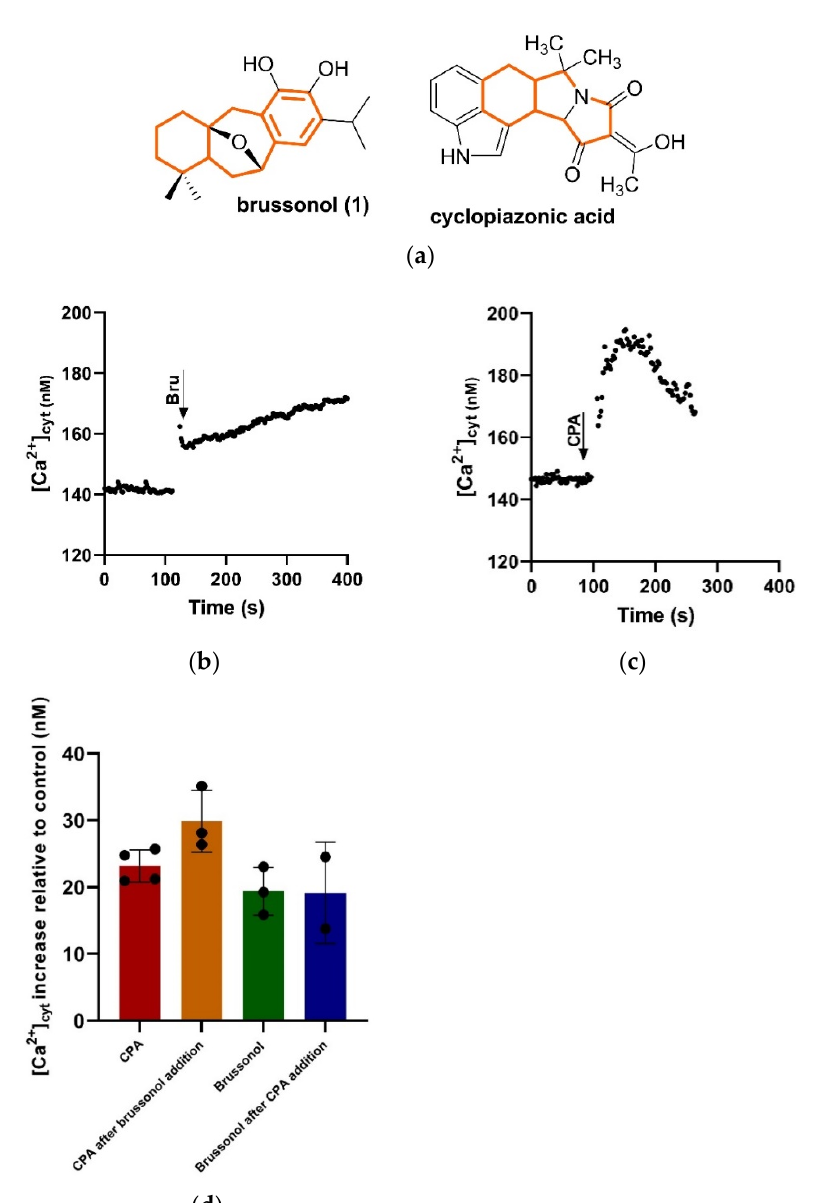
Figure 8 . Effect of brussonol on the cytosolic Ca 2+ mobilization in P. falciparum loaded with Fluo-4 AM calcium indicator. ( a ) Chemical structure of brussonol and CPA. The fused rings are highlighted for comparison purposes. Representative traces of [Ca 2+ ] cyt rise induced by 10 μ M brussonol ( b ) and 10 μ M CPA ( c ) in MOPS buffer containing Ca 2+ . ( d ) Histograms of the increase in the cytosolic Ca 2+ levels with the addition of CPA (10 μ M), brussonol (10 μ M), and brussonol (10 μ M) after and before treatment with CPA (10 μ M). The data analyzed were collected from two independent experiments.